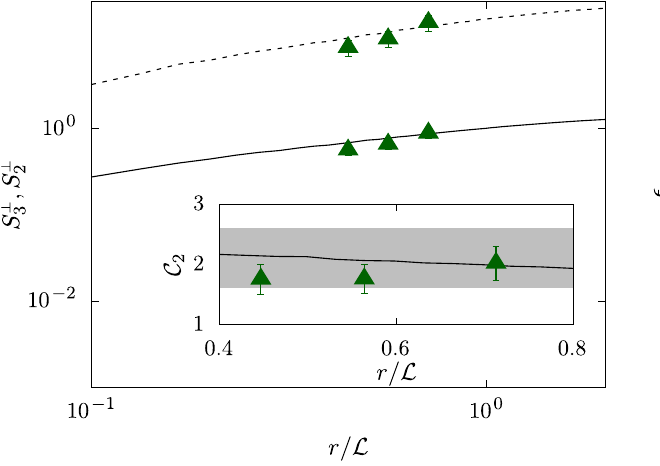
FIG. 9. Comparison between the turbulence dissipation rate FIG. 8. Second-order and third-order transverse velocity ˜ S ⊥ evaluated with FTVand PTV. The green line represents the value structure functions from experiments (note that 3 is computed obtained by Eq. (8) from the nylon fibers, and the green shadow is using the absolute value of the velocity difference). Solid and the relative tracking error. The black triangles are evaluated dashed lines indicate the standard particle tracking measure- k ˜ S ⊥ = ð 4 r Þ , relying on the turbulence through the PTV data as ϵ ¼ − S ment for S ⊥ 2 and 3 5 3 , respectively, while symbols denote those isotropy. The bars represent the error related to statistical obtained from Lagrangian tracking of the fibers. The bars convergence. All quantities are made dimensionless with the represents the error related to the velocity measurement. All integral scale L and the root-mean-square velocity. The turbu- quantities are made dimensionless with the integral scale L and ˜ S ⊥ lence is generated by smooth wheels rotating at 150 rpm the velocity root-mean-square; 3 is multiplied by 10 to (a complete characterization of the turbulence properties gen- enhance the visualization. The inset shows the Kolmogorov erated by smooth wheels can be found in Ref. [39]). constant C 2 computed according to Eq. (6) using both methods; the gray area denotes the range of values determined exper- imentally by Noullez et al. [35]. Turbulence is generated by rough wheels rotating at 400 rpm.